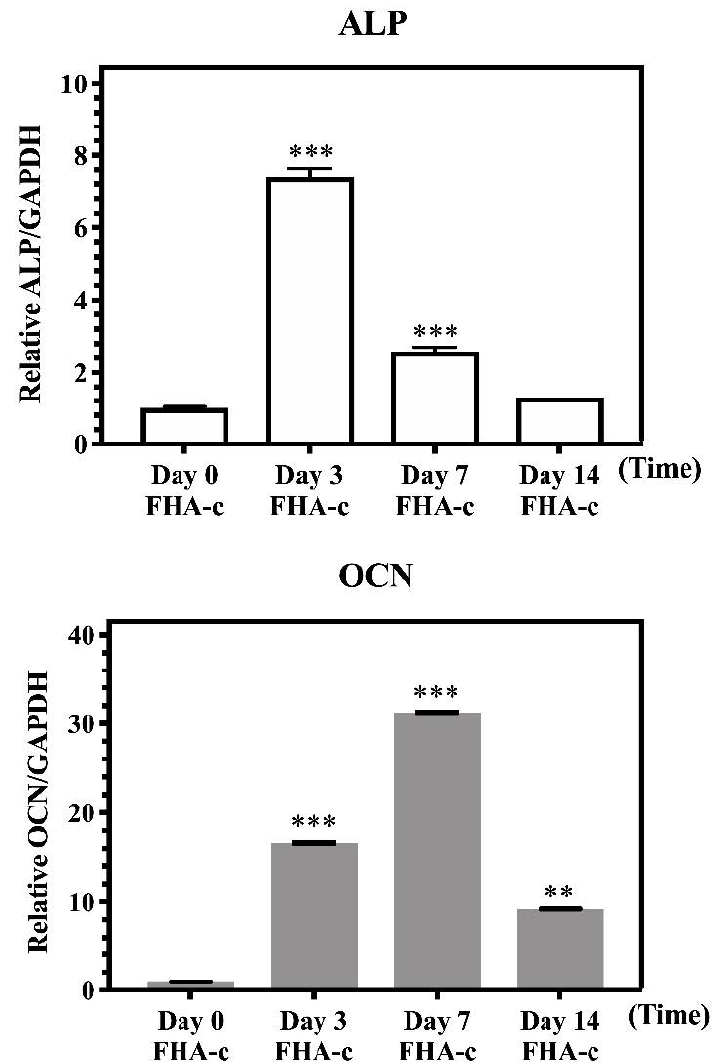
Figure 8. qPCR analysis of osteogenic (ALP and OCN) gene expression in hMSCs cultured on FHA-Mg scaffolds under osteogenic differentiation for 0, 3, 7, and 14 days. Relative gene expression indicates fold change of gene expression in comparison with that of undifferentiated hMSCs at day 0. All data are expressed as mean ± standard deviation (SD). Values shown are mean ± standard error ( n = 3). ** p < 0.01, *** p < 0.001 as compared to day